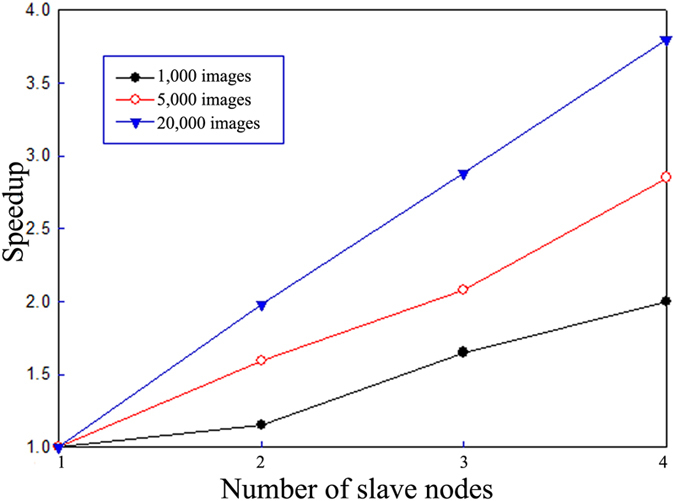
Speedup comparison.